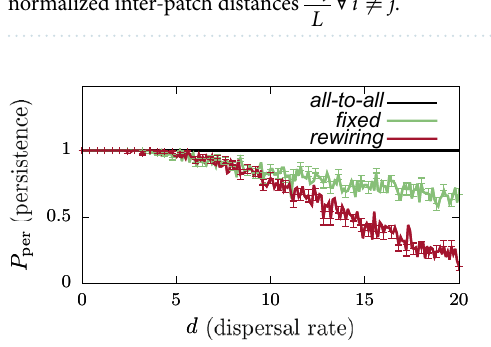
Figure 2. Patch characteristics for NPC with N patch area parameter β i . ( b ) pair-wise connectivity for the homogeneous patch case with β i normalized inter-patch distances